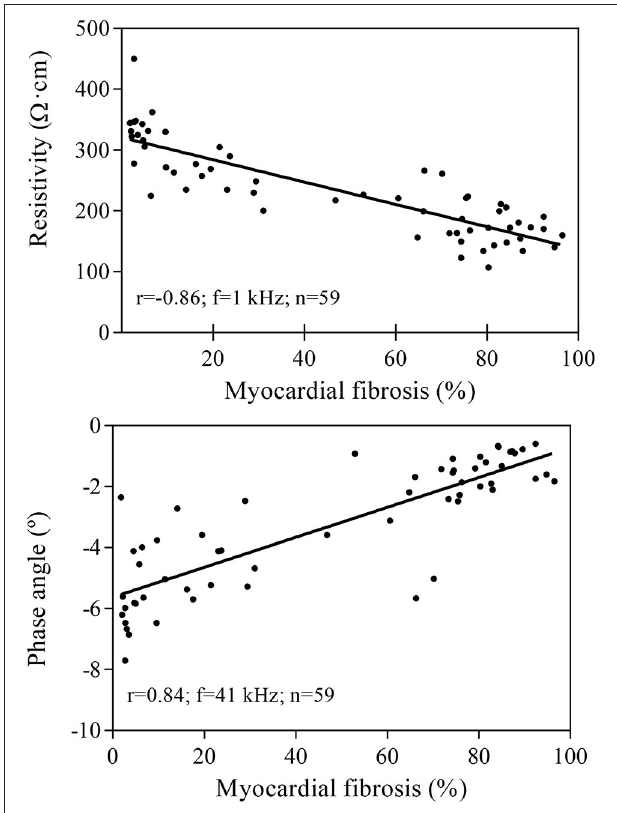
FIGURE 4 | Linear correlation between the local degree of myocardial fibrosis and myocardial resistivity (upper panel) or phase angle (lower panel) in 59 samples from six pigs. Resistivity values are measured at 1kHz and phase angle at 41kHz.